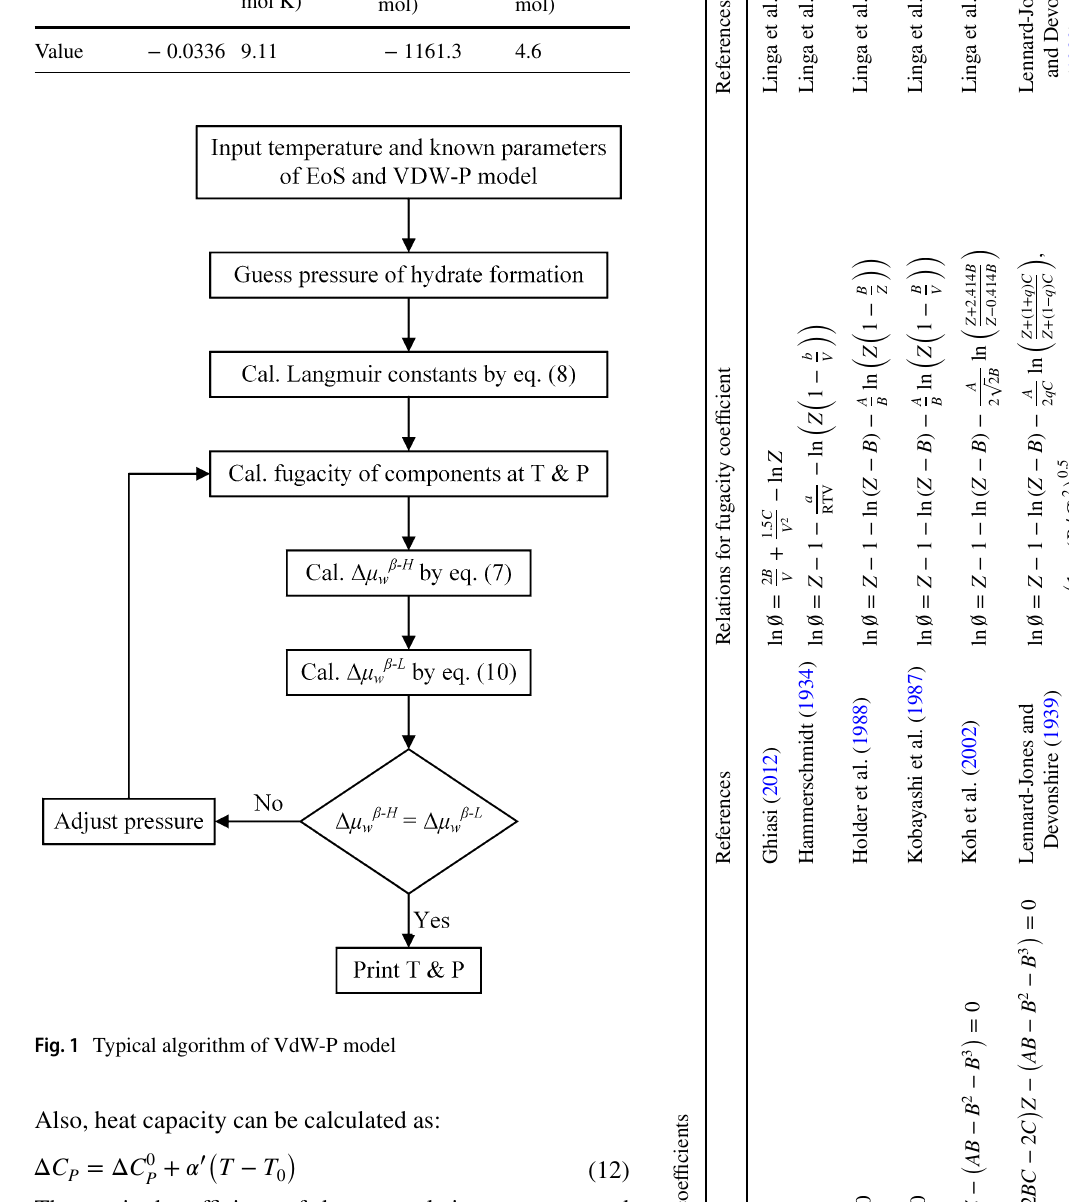
Fig. 1 Typical algorithm of VdW-P